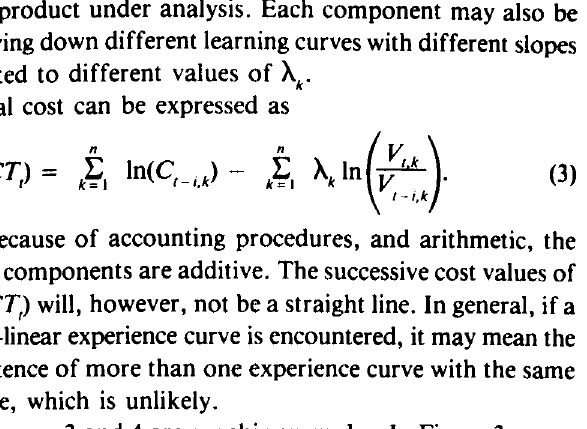
Figure 3 Total cost and individual cost curves for a three component product